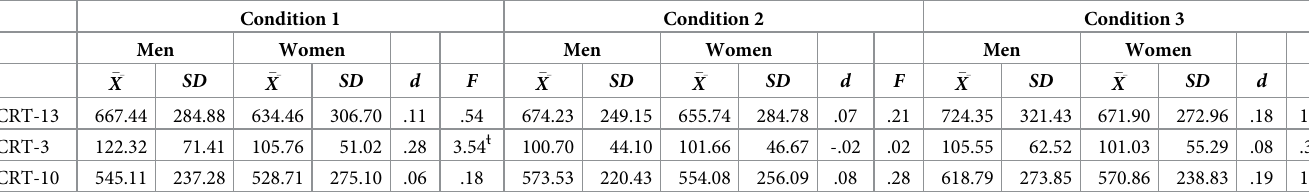
Table 5. Sex differences in CRT response time (in seconds) according to experimental